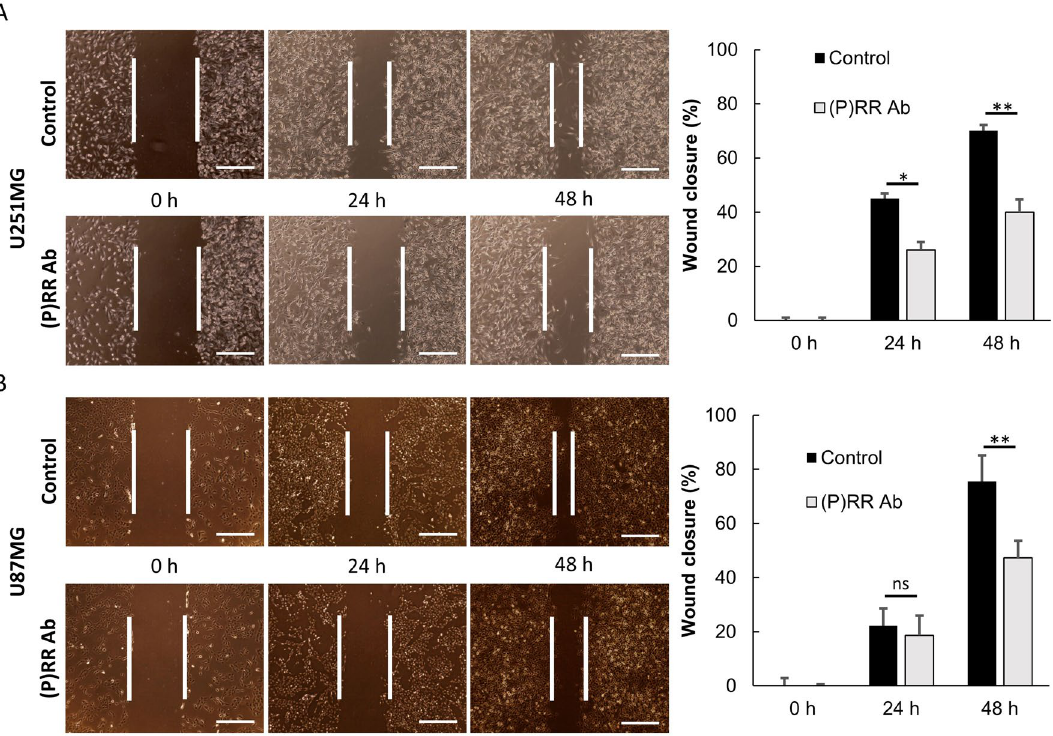
Figure 6. Effects of (P)RR Ab silencing on the migration of glioblastoma cell lines. Migration were evaluated in ( A ) U251MG and ( B ) U87MG by the wound healing assay. Cells were treated with 400 µg/mL of (P)RR Ab. Representative images were captured at 0, 24 and 48 h after scratching (scale bar = 75 µm). The white line shows the borders created by the original scratch. A graphical percentage of the wound closure in ( A ) U251MG and